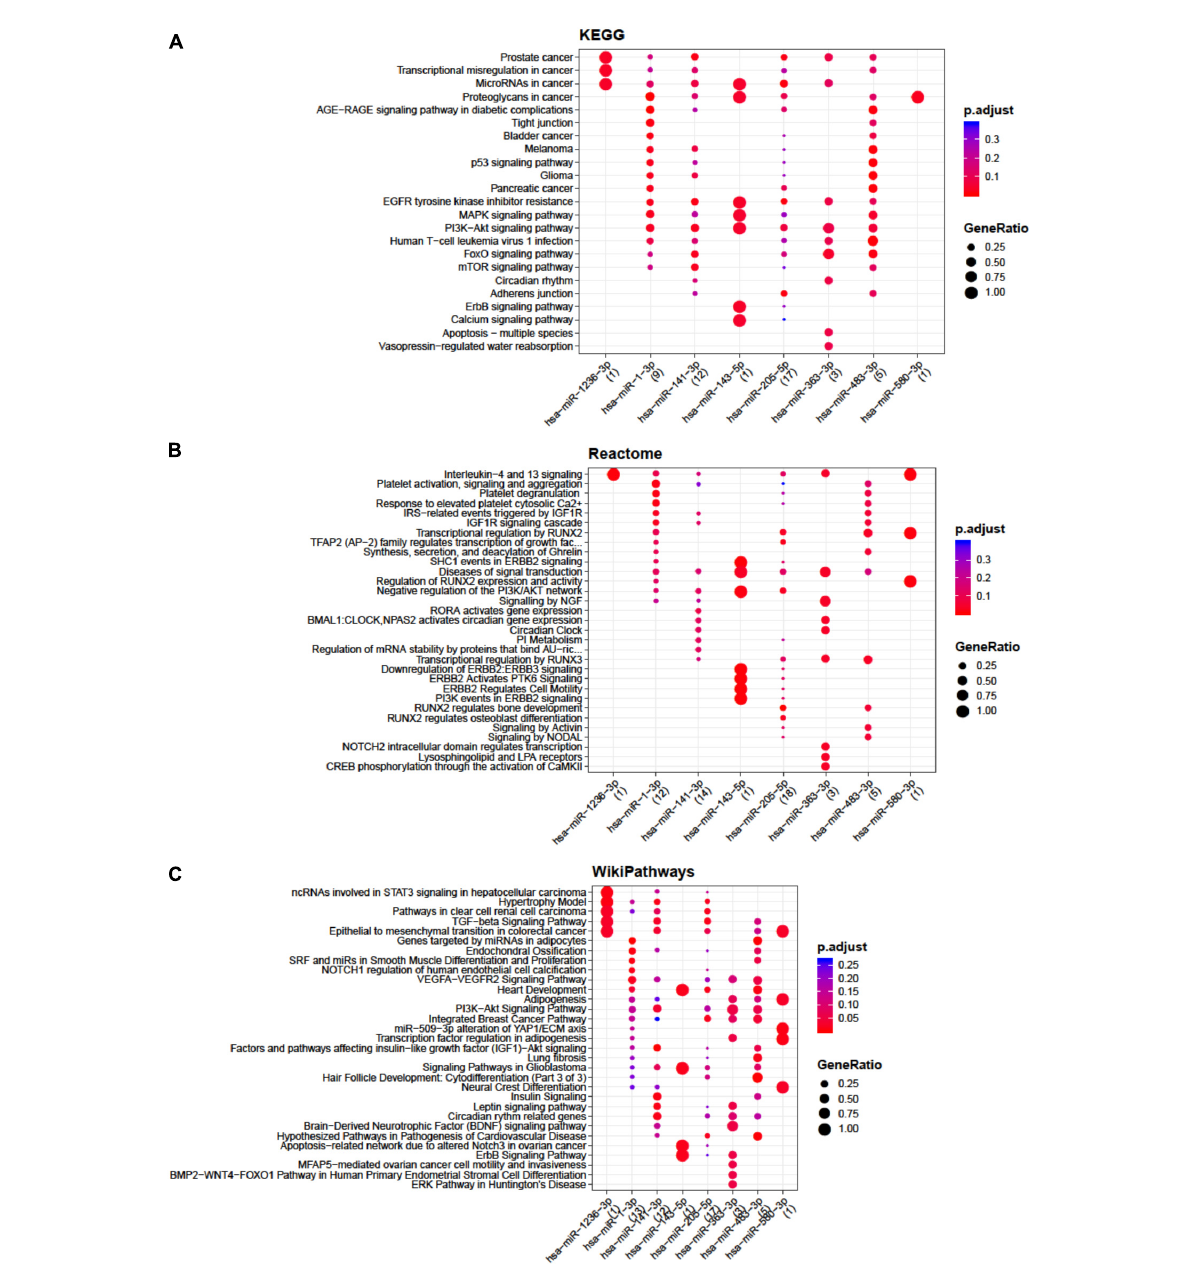
FIGURE2 Functional enrichment analysis on micro RNAs (miRNAs) selectively expressed by bone marrow-derived stem cells (BMSCs). The analysis was conducted by KEGG pathway (A) , Reactome (B) , and Wikipathway (C) . Significant pathways are listed and represented by circles colored according to the significance of the enrichment and their size is proportional to the number of target genes regulating the described signaling pathways.